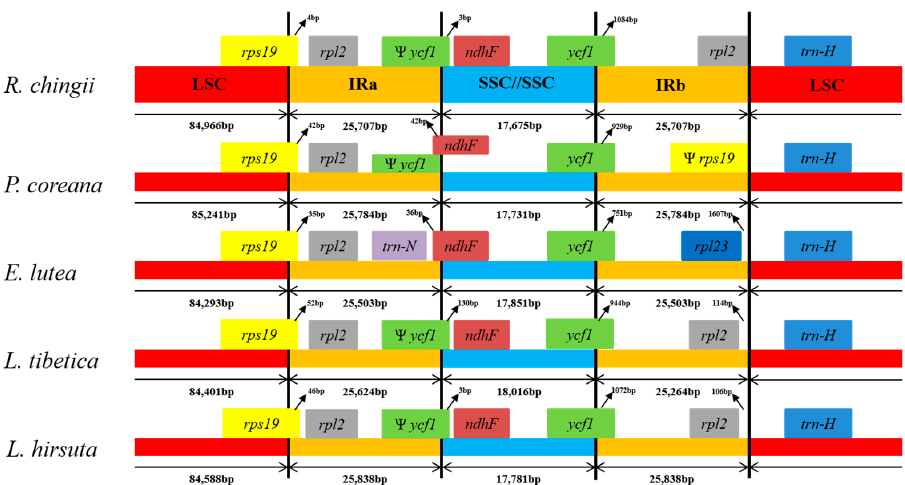
Figure 3. Comparison of the borders of large single-copy (LSC), small single-copy (SSC), and inverted repeat (IR) regions among the chloroplast genomes of five species.